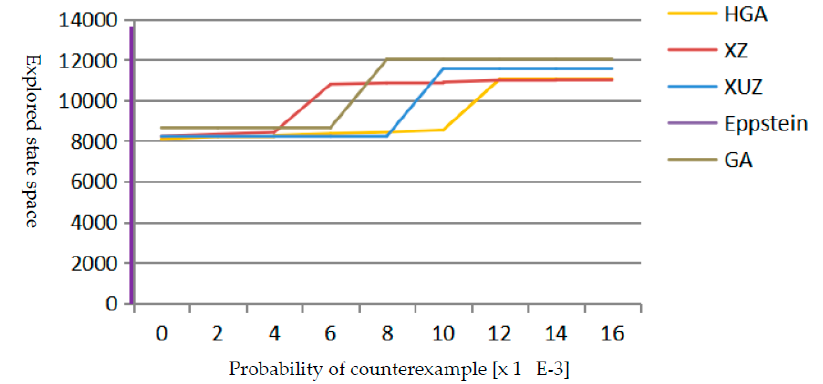
Figure 6. Counterexample probability of power dynamics management.